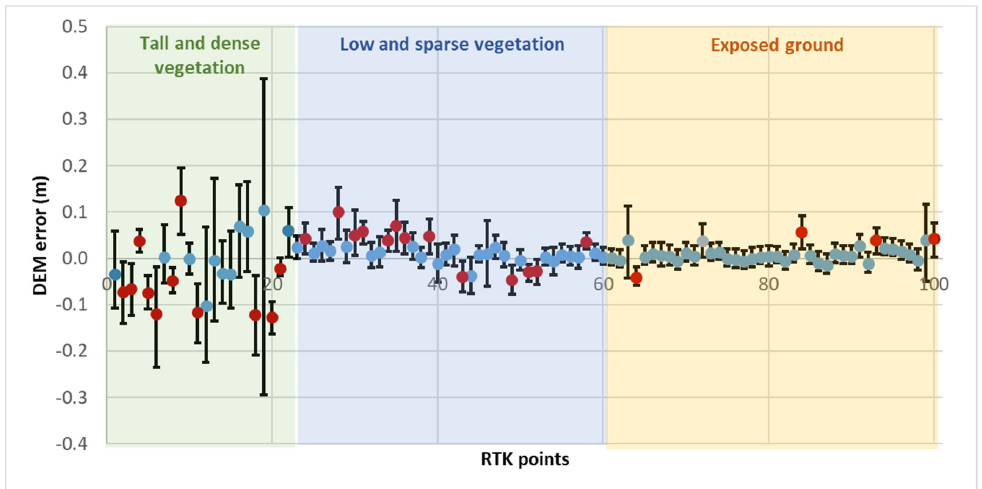
Figure 11. Corrected DEM error and estimated 95% tolerance intervals / uncertainty ranges of the error corrections for the six-input ENN compared with the 100 independent RTK points. Referring to the dots, positive values indicate that the corrected DEM elevations are higher than the RTK ground truths. Zero values indicate that the corrections are equal to the RTK values. Negative values indicate that the corrections are lower than the RTK points. The bar represents the tolerance interval for each correction. Red dot indicates that the tolerance interval did not include the RTK elevation. Grey dot indicates that the tolerance interval did include the RTK elevation.